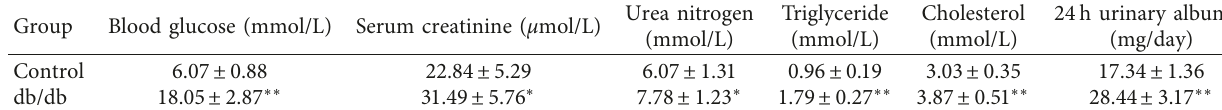
Table 1: The biochemical indicators of control and 12-week db/db mice ( x ± SD, n � 6). Group